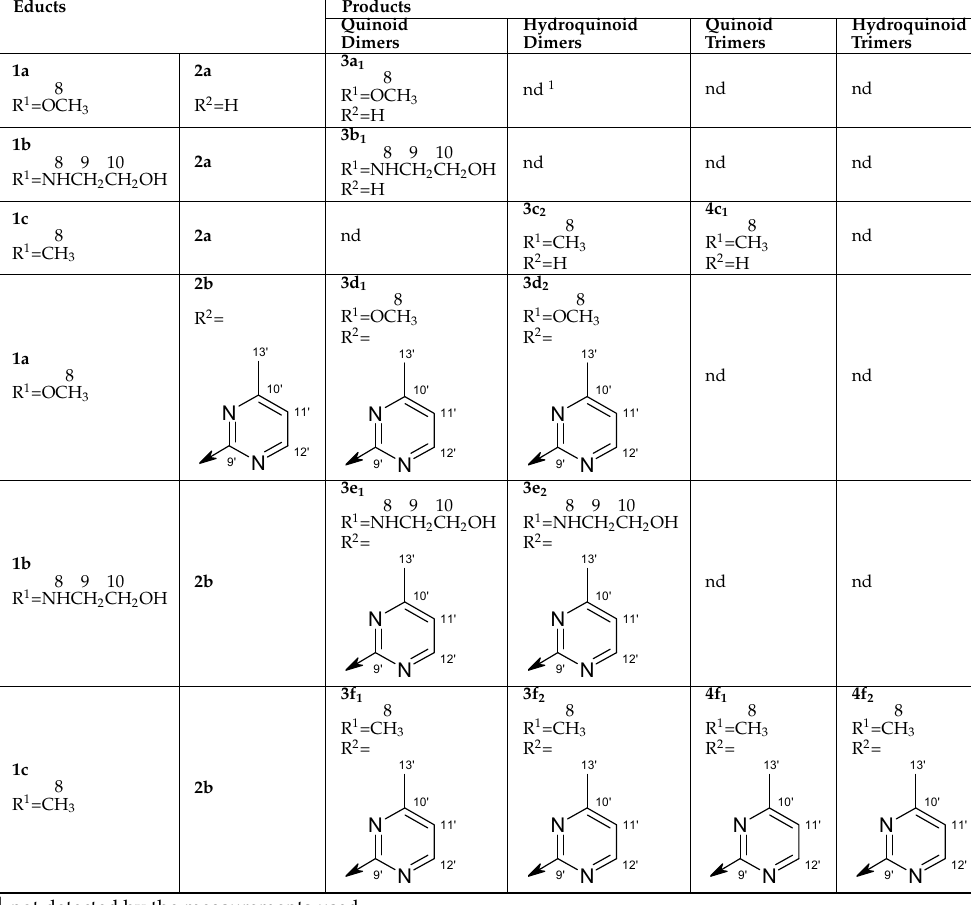
Table 1. Heterodimers and heterotrimers produced by laccase-mediated reactions of 2,5-dihydroxybenzene derivatives ( 1a – 1c ) and sulfonamides ( 2a , 2b ). Educts Products Quinoid Hydroquinoid Quinoid Hydroquinoid Dimers Dimers Trimers Trimers